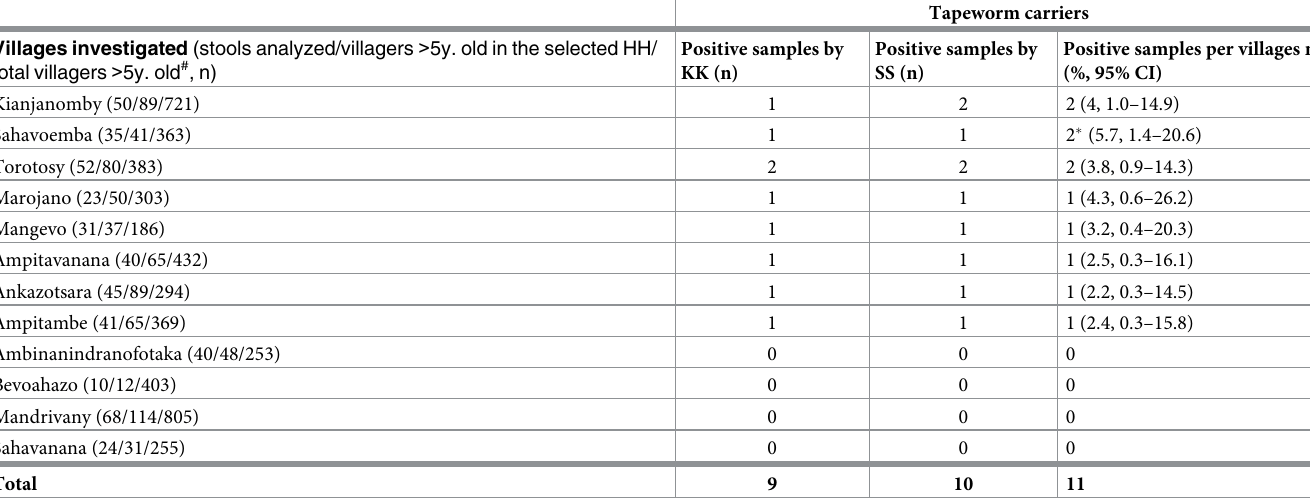
Table 2. Prevalence of taeniosis by villages investigated. Results obtained after stool analysis by Kato-Katz (KK) or sedimentation assays (SS).